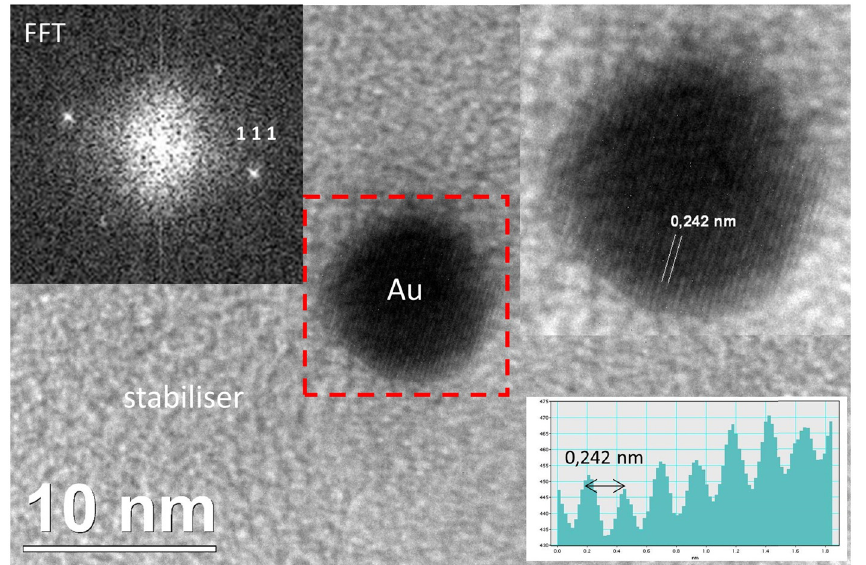
Figure 7: HRTEM image of an AuNP with FFT simulation taken from the area of the red dashed square around the AuNP, the AuNP with visible atomic planes 0.242 nm, and the corresponding pro fi le across the atomic